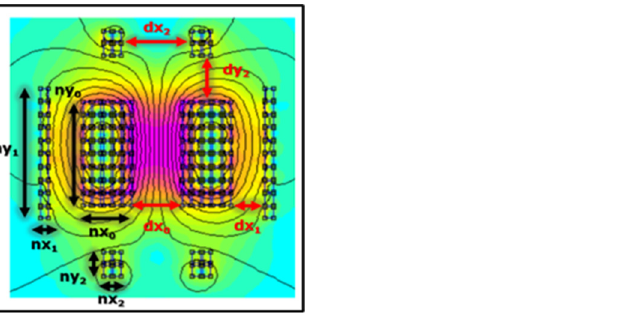
Figure 4. Parameter configurations with canalization of the induction field in background.